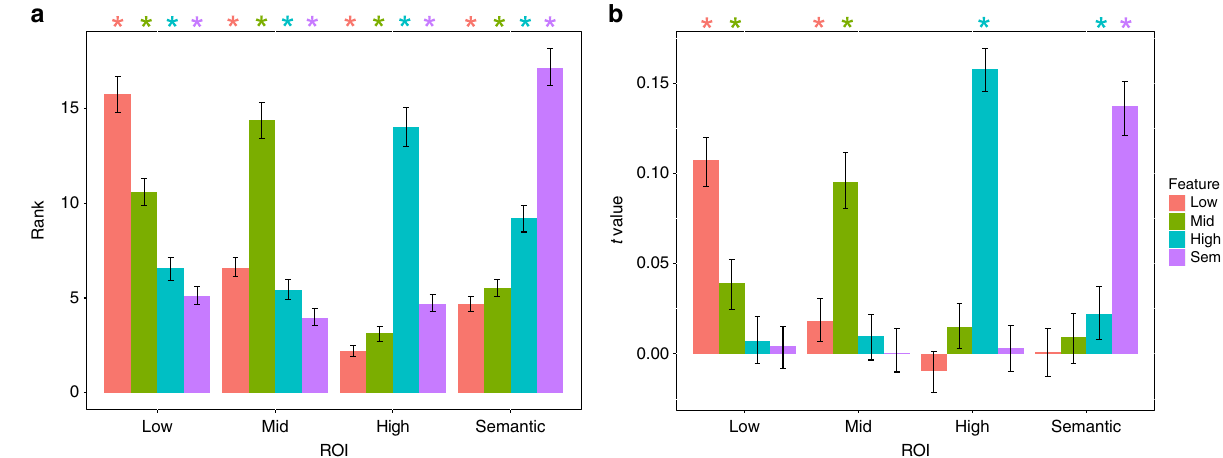
Fig. 3 Simulated results for decoding accuracy and feature-speci fi c informational connectivity. fMRI data was simulated (200 simulated subjects; see Methods section) and then run through the processing pipeline for FSIC (see Methods section) to validate the approach. ROIs only contain features from the indicated feature-level. a Image classi fi cation performance (rank measure) for all combinations of ROI and feature-level. Correlations between feature- levels result in the classi fi cation accuracy measure falsely indicating the presence of features that are not present within the target ROI. b FSIC results for all combinations of ROI and feature-level assuming identical trial-by-trial memory accuracy across feature-levels. A separate seed was used for each feature-level corresponding to that feature-level (the results are also depicted in Supplementary Fig. 4b along the diagonal). Signi fi cant FSIC results only indicate the presence of the feature-level contained within each ROI, except for relatively weak evidence for the presence of adjacent feature-levels (e.g., a signi fi cant effect associated with mid-level features was found within the low-level ROI). Error bars are 90% CIs; *indicates p < 0.05, one-tailed bootstrap, FDR